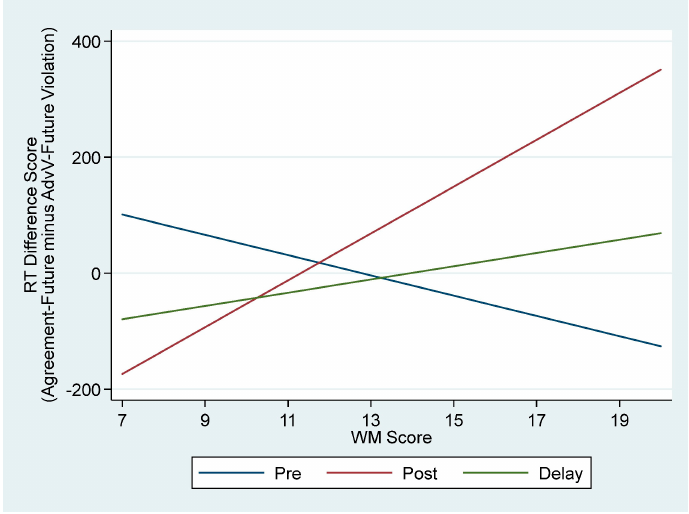
Figure 9. Time × Working Memory Interaction (AdvV-Future Outcome) for Training Participants, Indicating the Predicted Reading Time Difference Scores at Each Test Time Based on WM